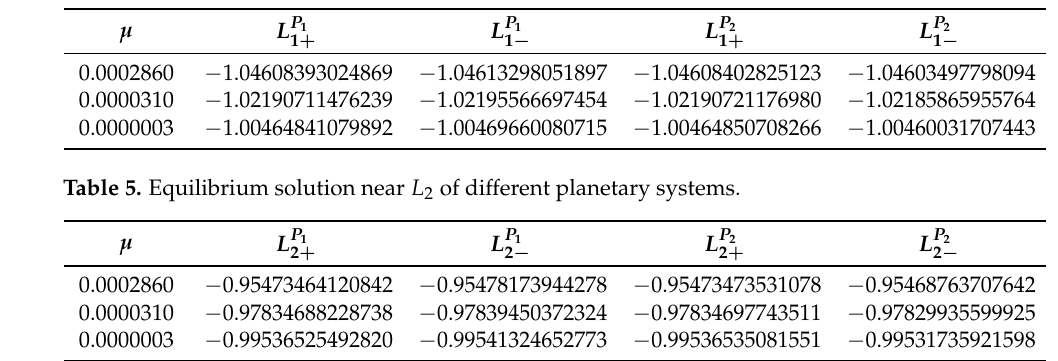
Table 4. Equilibrium solution near L 1 of different planetary systems.